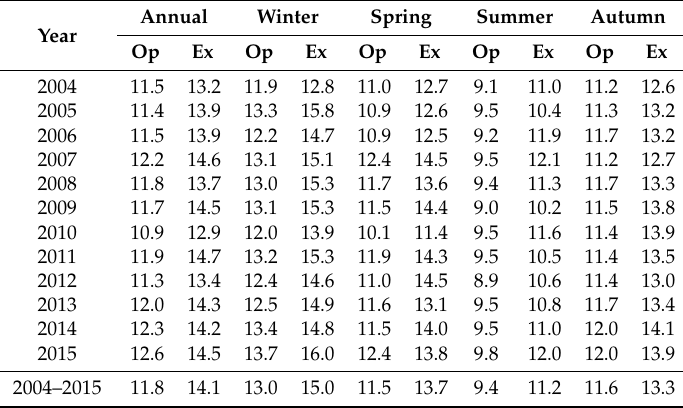
Table A7. Annual and seasonal Op and Ext T E thresholds (s) at BA.